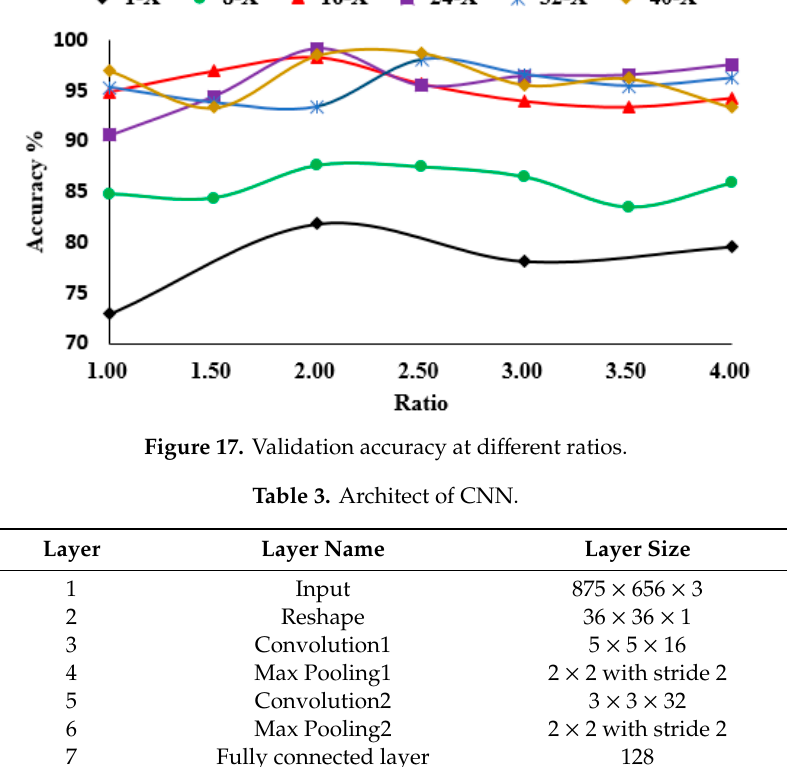
Figure 16. Radiation sound pressure levels with different leak diameters. (a) 0.30 MPa; (b) 0.25 MPa; (c) 0.20 MPa; (d) 0.15MPa.